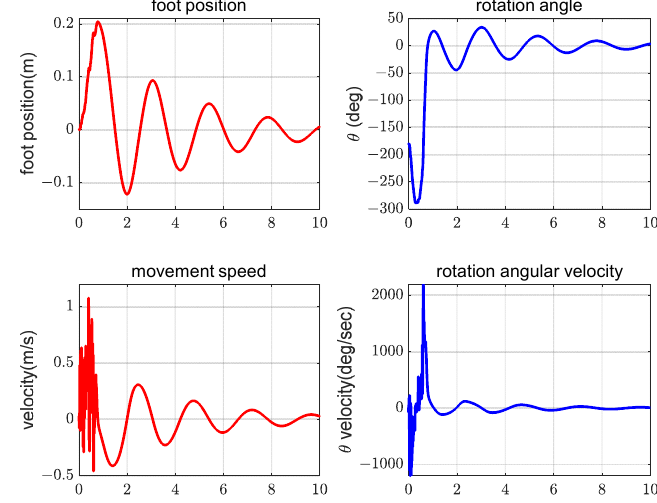
Figure 7. PID control without interference.